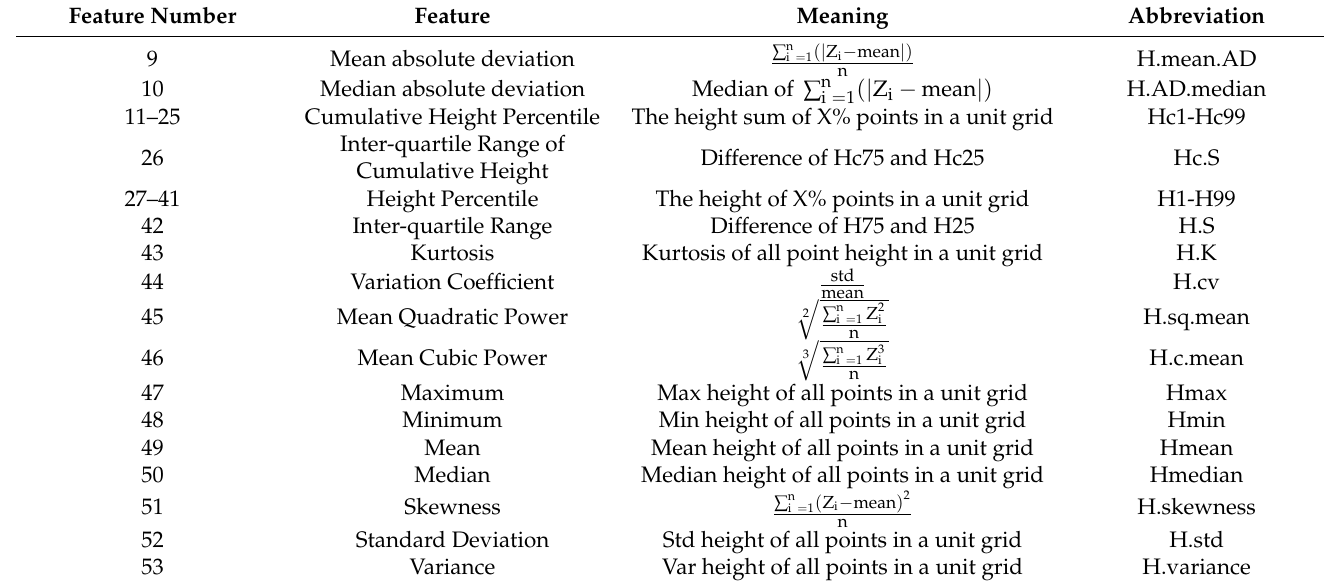
Table 6. Features describing the point cloud vertical distribution using heights.